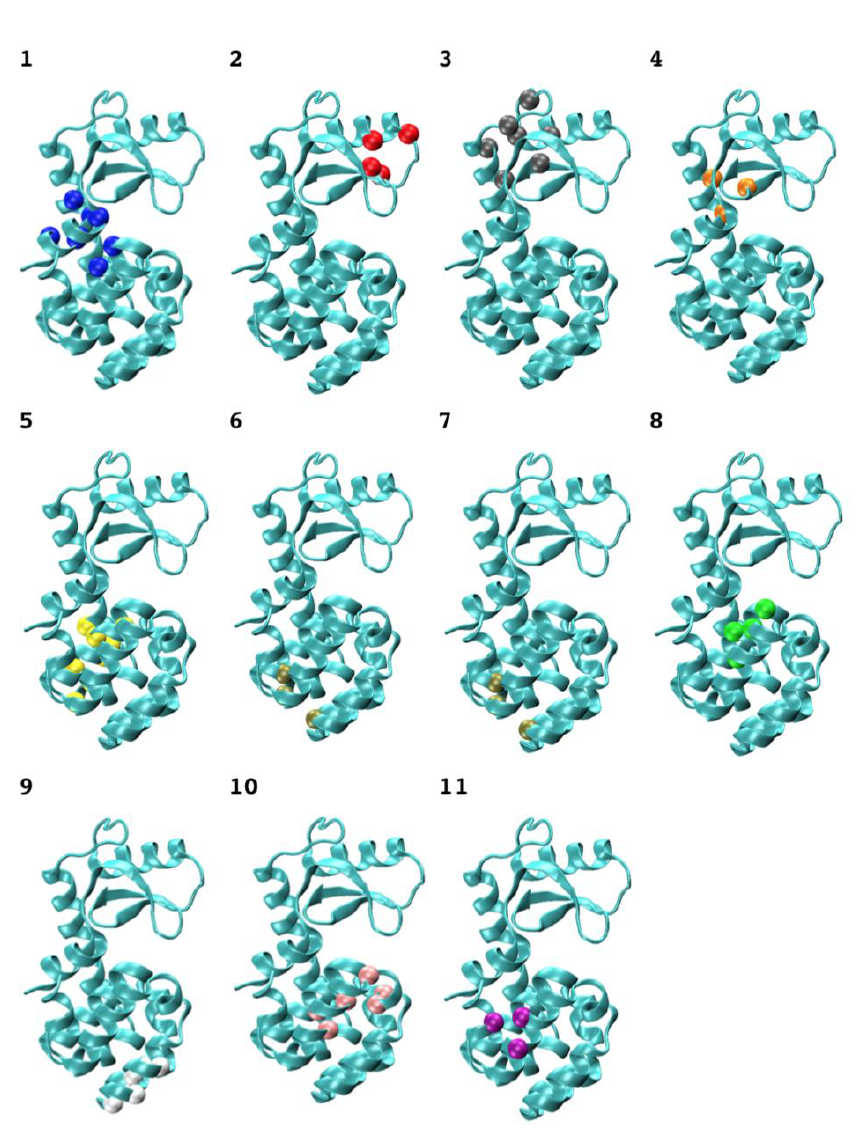
Figure 3. The typical 3-cliques of an amino-acid network of the T4 phage lysozyme. The clique nodes are represented by α -carbon as shown in a ball, and the labels correspond to the factions listed in Table 2.